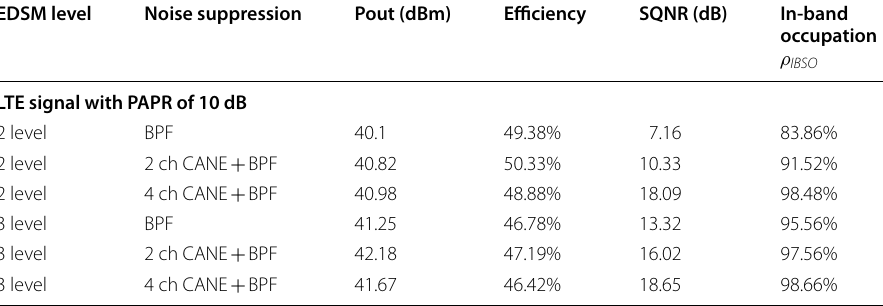
occupation ρ IBSO